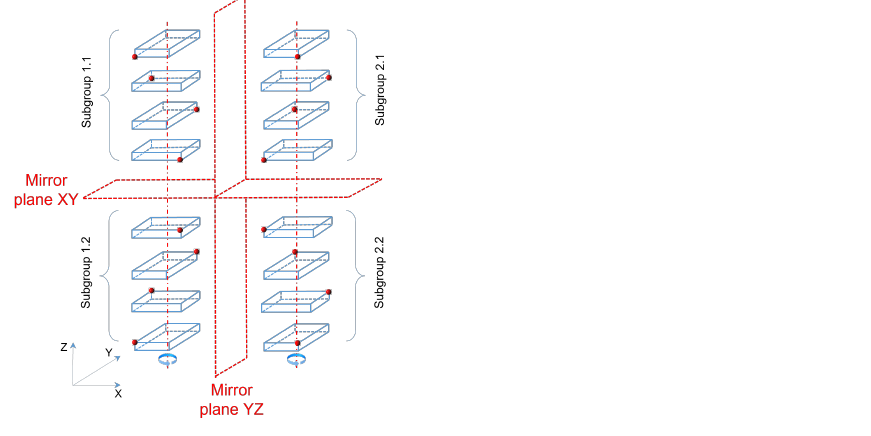
Figure 3. Impact of instrumentation on the combinatory of the problem due to the position of the node on the